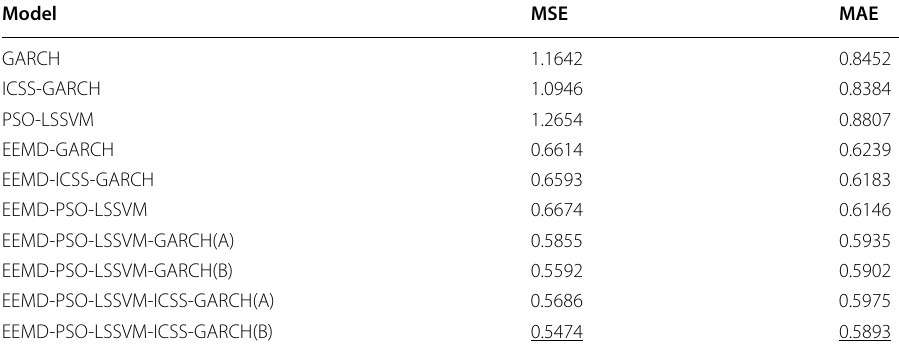
Table 6 1‑Day ahead forecasting results for daily log‑returns of the AIRO index under alternative sample